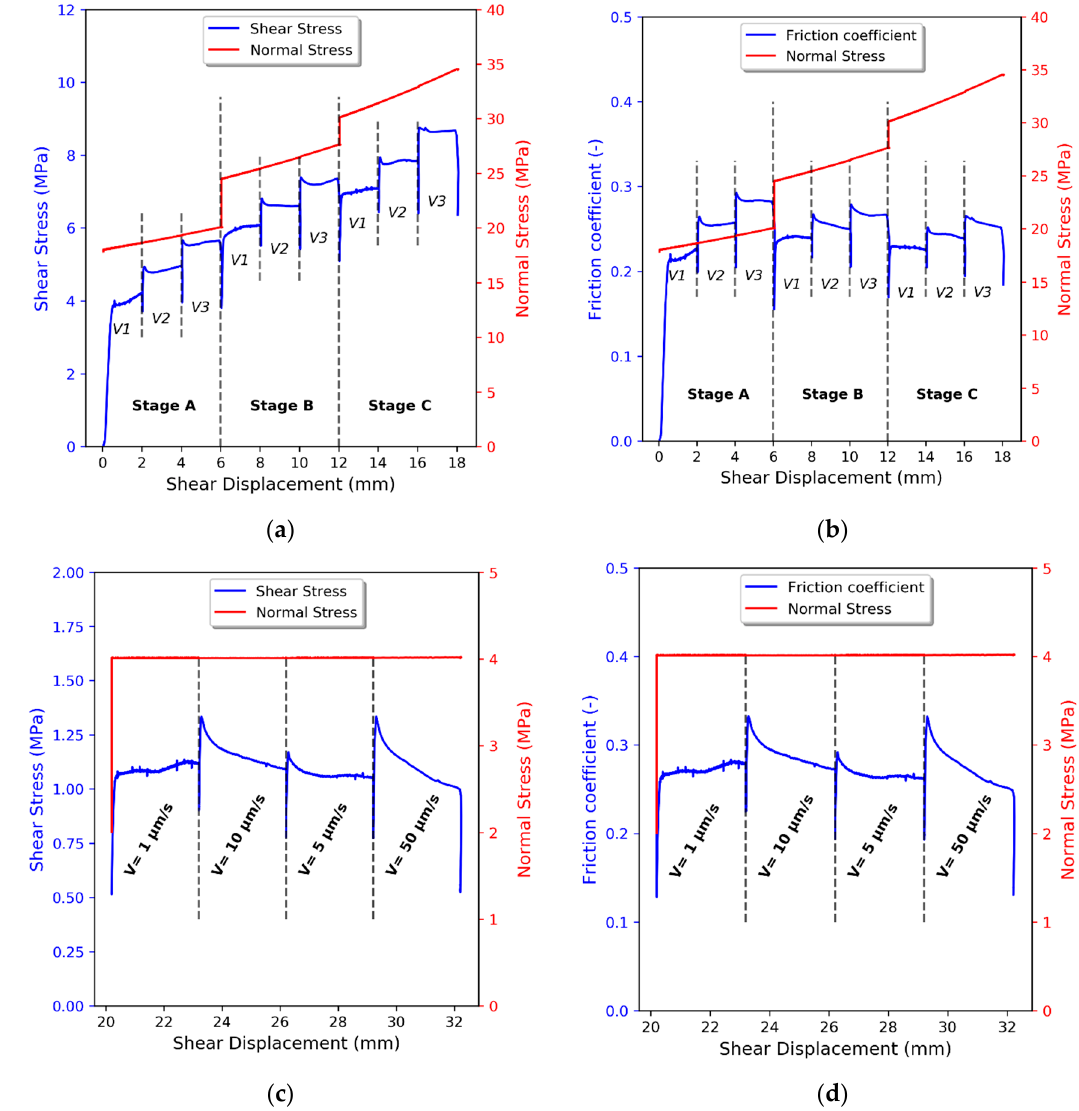
Figure 8. Evolution of shear stress and friction coefficient versus shear displacement for Draupne DST15 ( a , b ) following the constant normal load procedure at three different shear velocities ranging from 1 to 50 µm/s and ( c , d ) Draupne DST17 with constant normal stress procedure at four different shear velocities ranging from 1 to 50 µm/s.